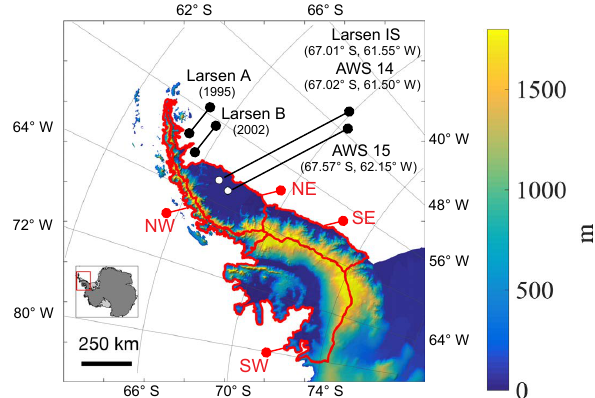
66° Figure 1. Full MAR domain showing topographic relief from bedmap2 (https://www.bas.ac.uk/project/bedmap-2, last access: November 2017) at 1km, former ice shelves with dates of collapse, locations of automatic weather stations (Larsen IS and AWS 14 sta- tions are located within the same MAR grid-cell) and basins corre- sponding to SW (basin 24), NW (basin 25), NE (basin 26), and SE (basin 27) from Zwally et al.